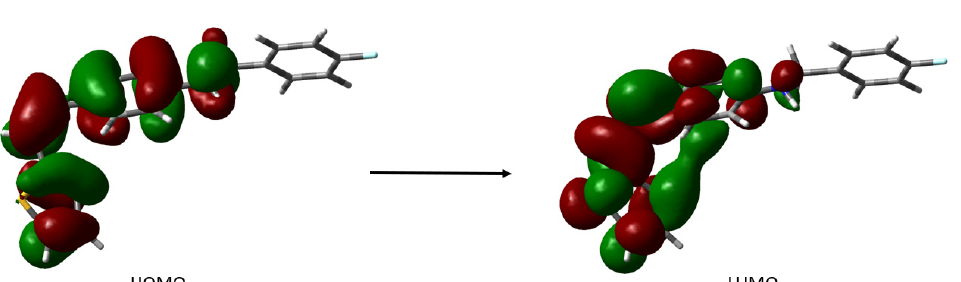
Figure 7. Canonical molecular orbitals involved in transition in UV-Vis spectra of compound cis - 2 .